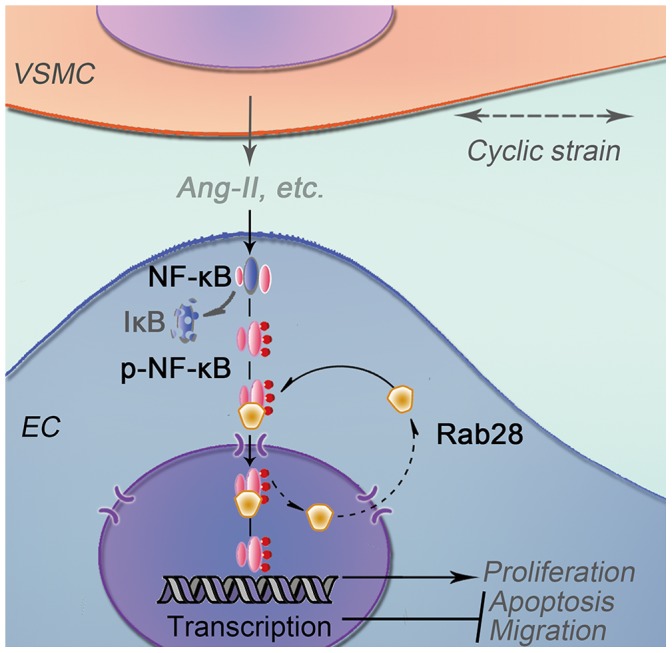
Schematic drawing outlines the possible role of Rab28 in EC homeostasis.Pathological cyclic strain loading on VSMC activates the local angiotensin system. VSMC secretes Ang II into the intercellular space (conditioned medium). Ang II induces the expression and translocation of Rab28 in ECs, which aids the NF-κB nuclear transporting and activation. Then the activated NF-kB eventually modulates gene transcription in charge of EC proliferation, apoptosis and migration.